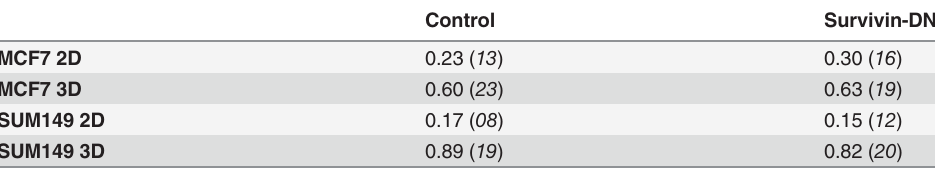
Table 1. Survival Fraction at 2 Gy for survivin-DN in MCF7 and SUM149.